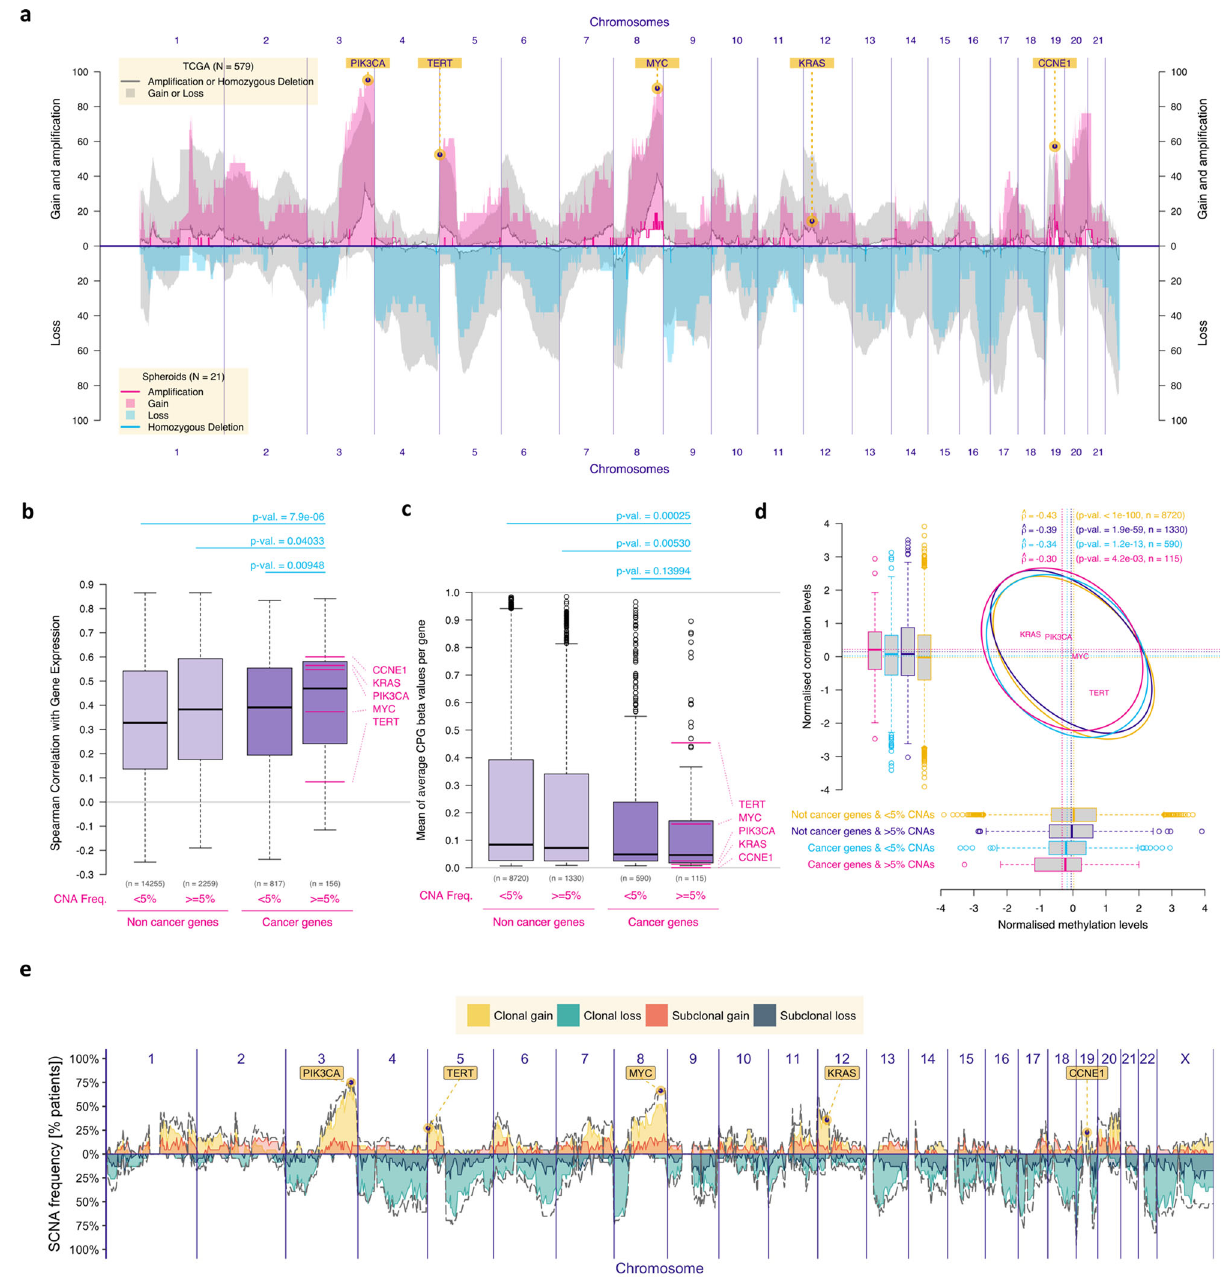
Fig. 2 | Genomic analysis of single and multi-regional HGSOC cohorts de fi ned clonal SCNA driver genes. a Plot showing the prevalence of chromosomal alterationsacrossthegenomeinboththeTCGAcohort( n =579)andintheHGSOC spheroidsamplesfromtheOV04cohort( n =21).Forthespheroidcohort,gainwas de fi ned as 3 or 4 chromosomal adjusted copies and ampli fi cations as ≥ 5 adjusted copies. b Boxplots showing the Spearman ’ s correlation scores between gene expressionandrespectivechromosomalcopynumberforeachgene,splitbetween cancervsnon-cancergenesandprevalent(>5%SCNAsinHGSOC)vsnon-prevalent genes. Driver genes (in the far right; de fi ned as ‘ cancer genes ’ that have SCNA alteration frequency in ≥ 5% of the samples) had the highest positive correlation scores.Numbersabovetheboxplotscorrespondtothep-valuesobtainedwithtwo- sided Mann-Whitney-Wilcoxon tests. c Boxplots showing methylation levels (beta- values) for all genes, split as cancer and non-cancer genes and as prevalent (>5% SCNAs in HGSOC) and non-prevalent genes. Prevalent non-cancer genes were sig- ni fi cantlymoremethylatedthanprevalentcancergenes(two-sidedMann-Whitney- Wilcoxon ’ s p -value: 0.005). d 95% prediction con fi dence ellipses displaying the estimated Pearson ’ s correlation between the methylation levels (x-axis,